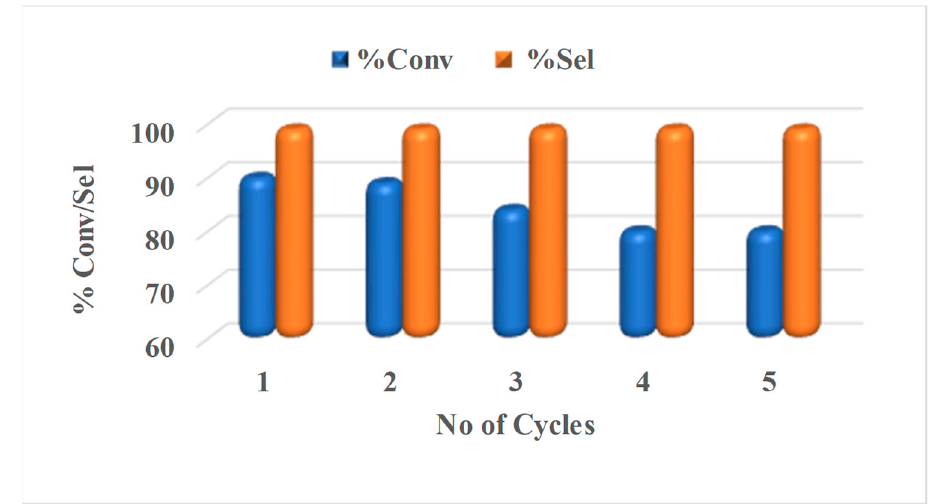
Figure 9. Reusability of Ag-Co/S for oxidation of CA to